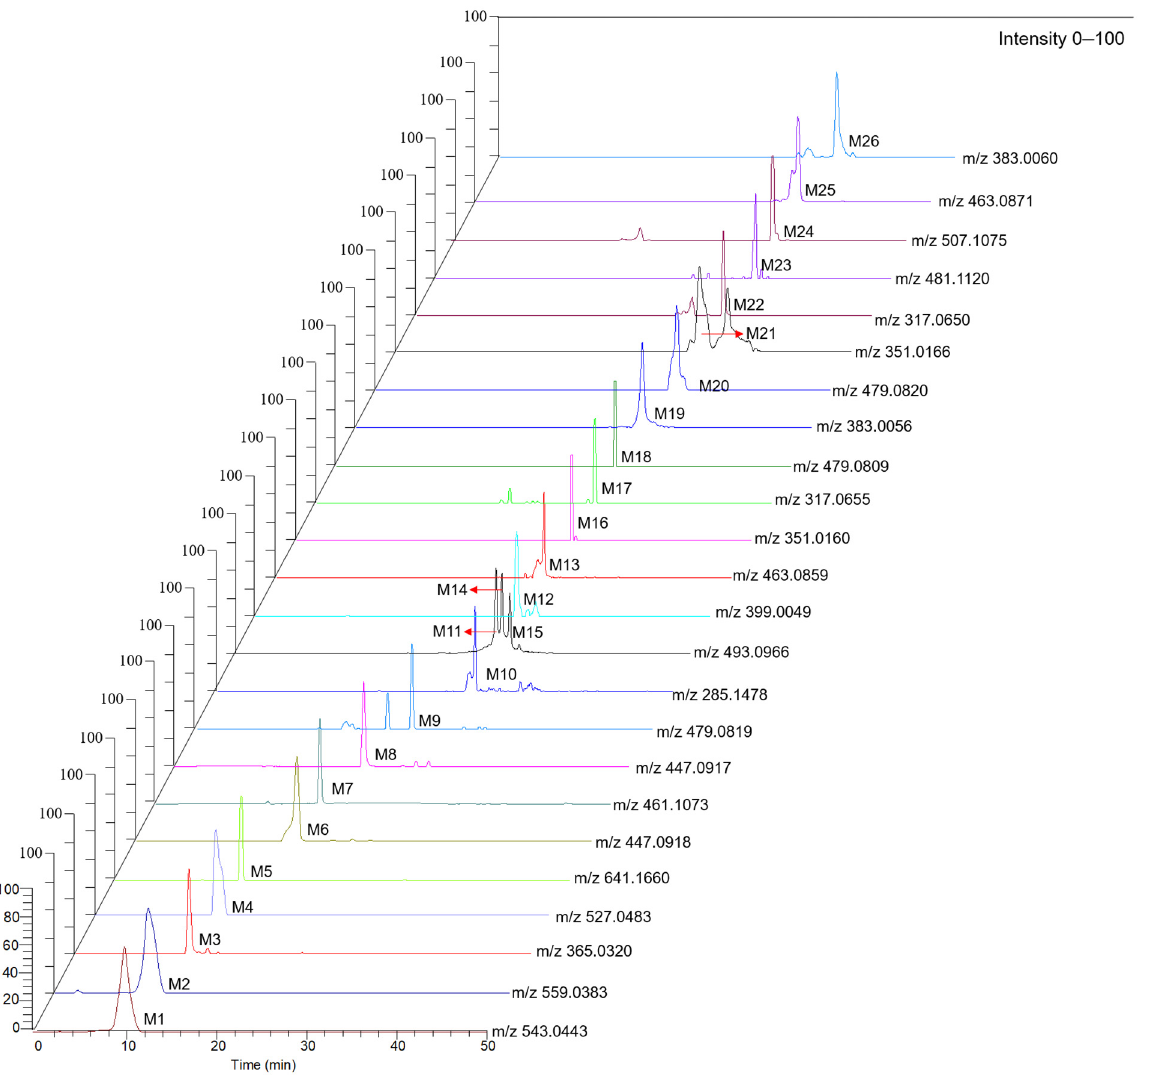
Figure 3. Extracted ion chromatograms of the novel metabolites of Tartary buckwheat extracts identified in rat plasma, bile, urine and feces after co-administration with ethanol. M19 (t R = 31.31 min) and M26 (t R = 37.00 min) displayed protonated molecular ions